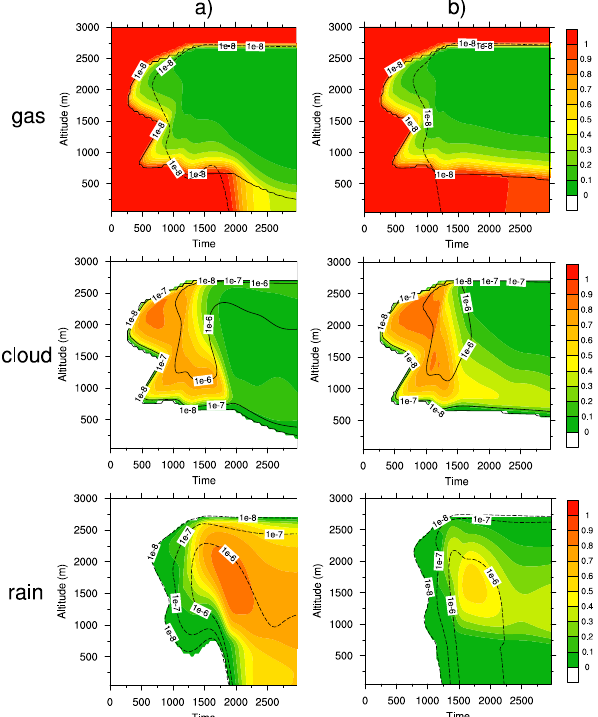
Figure 2. HaRP case: time evolution of vertical profiles at the centre of the cloud cell for 4 Fig. 2. HaRP case – time evolution of vertical profiles at the cen- hydrogen peroxide mixing ratio (ppbv) in gas phase, in cloud water and in rainwater: (a) using 5 tre of the cloud cell for hydrogen peroxide mixing ratio (ppbv) in the Kessler scheme and (b) using the C2R2 scheme. Isoline of cloud liquid water content 6 gas phase, in cloud water and in rainwater: (a) using the Kessler (vol/vol, solid line) and of rain liquid water content (vol/vol, dashed line) are superimposed. 7 scheme and (b) using the C2R2 scheme. Isoline of cloud liquid wa- ter content (volvol − 1 , solid line) and of rain liquid water content (volvol − 1 , dashed line) are